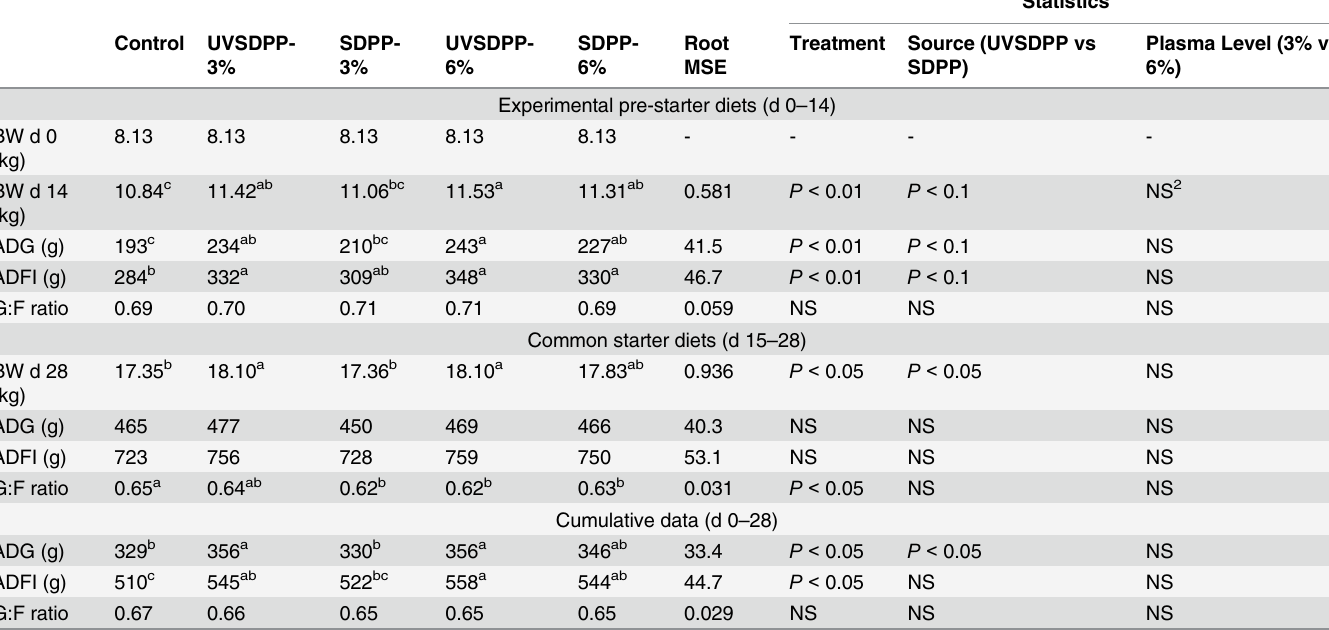
Table 5. Least squares means of productive parameters of pigs 1 fed diets with ultraviolet irradiated spray dried plasma (Experiment